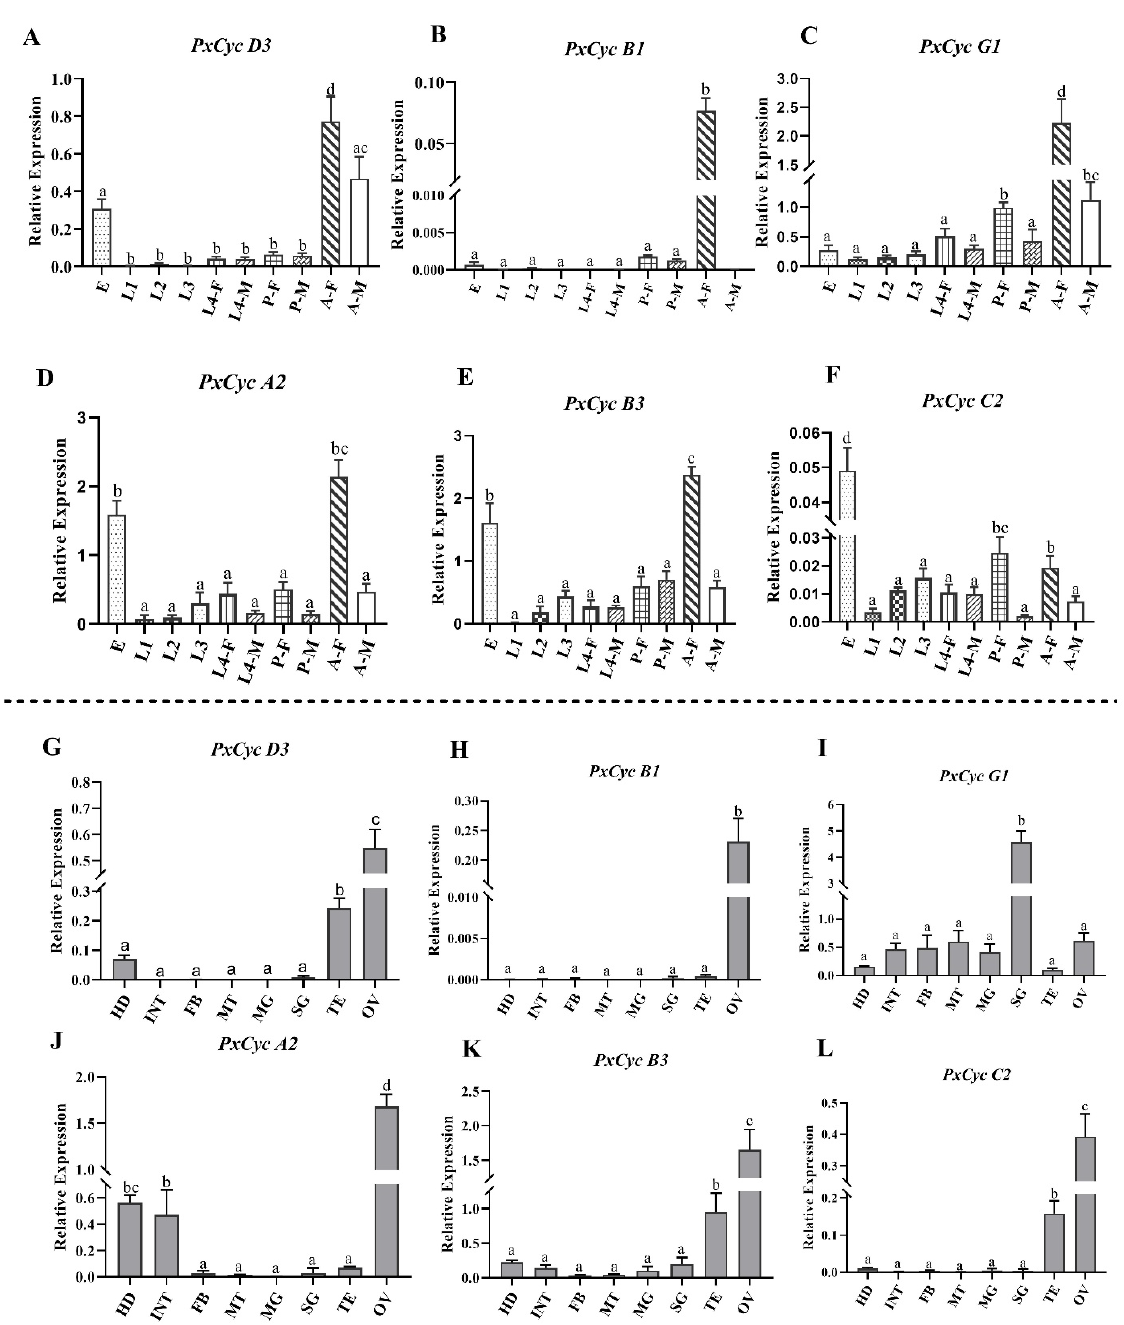
Figure 7. RT-qPCR-based validation of cyclin genes at various stages and tissues. ( A – F ), relative expression of six cyclin-like genes at different stages; ( G – L ), expression of six cyclin-like genes at different tissues. Bars represent the mean ± SEM of three biological replications; different letters highlight the significant difference in relative expressions among the different stages and tissues. Eg, egg; L1, first-instar larva; L2, second-instar larva; L3, third-instar larva; L4-F, fourth-instar female larva; L4-M, fourth-instar male larva; P-F, female pupa; P-M, male pupa; A-M, adult male; A-F, adult female; HD, head; INT, integument; FB, fat body; MG, midgut; MT, malpighian tubule; SG, silk gland; TE, testis; OV, ovary.